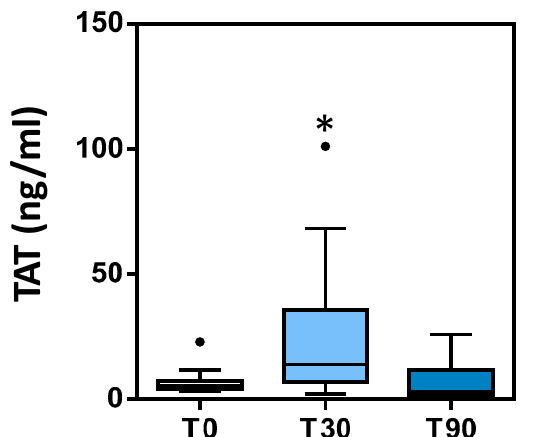
Figure 3. TAT levels measured at T0, T30 and T90. Circles in the plot area represent outliers. * p < 0.05 vs. 0.05 vs. T0.